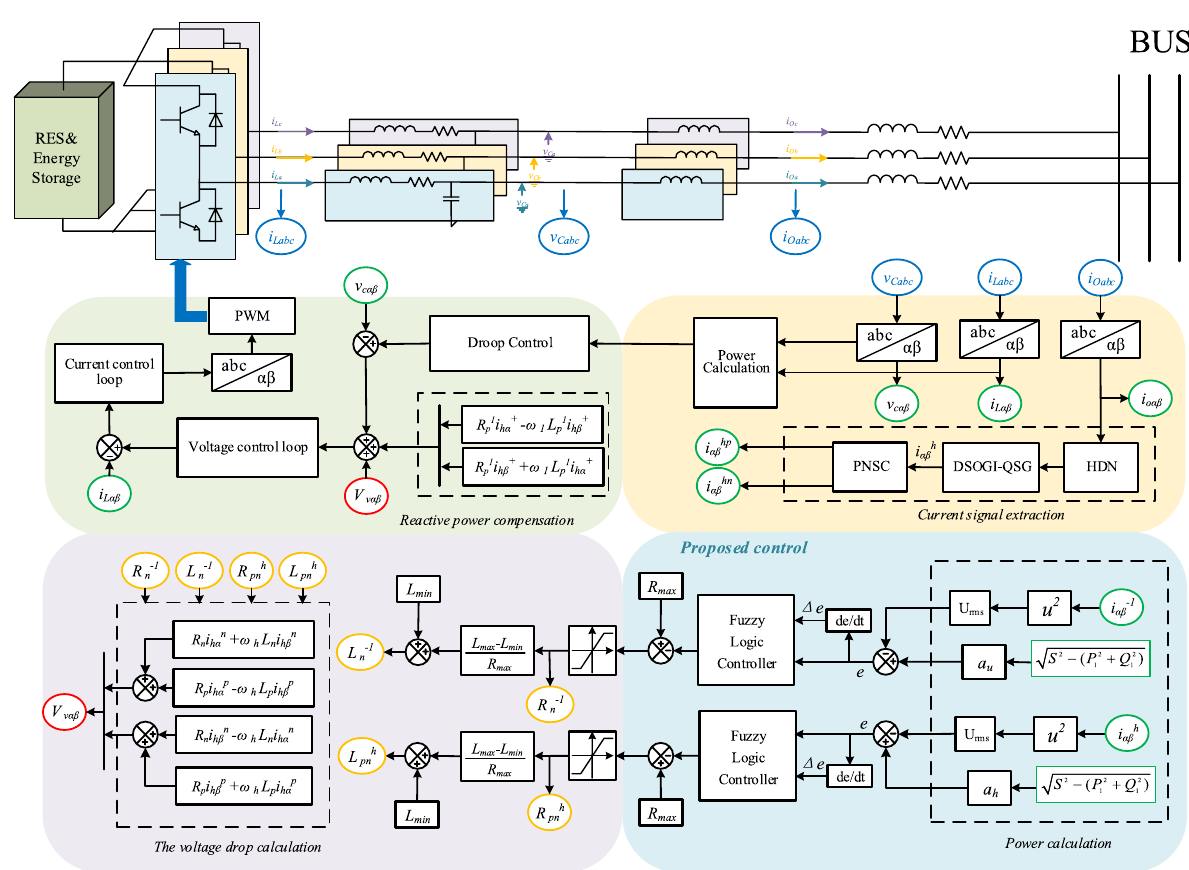
Fig. 15 Overall diagram of the proposed control